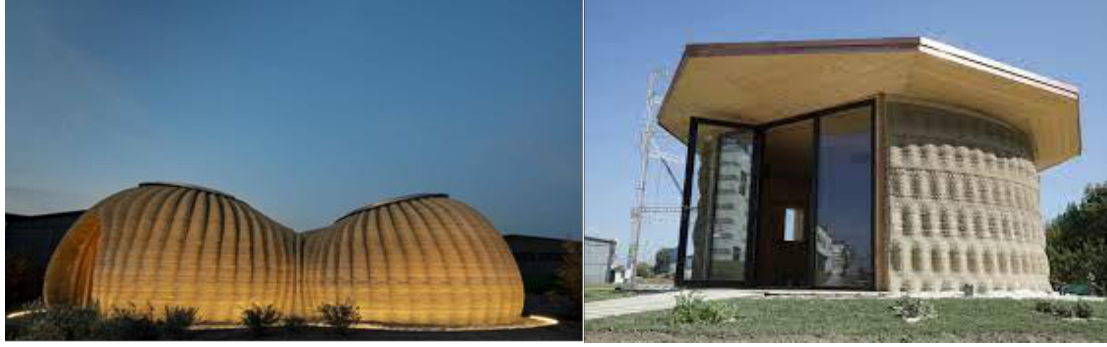
Source: the architect newspaper